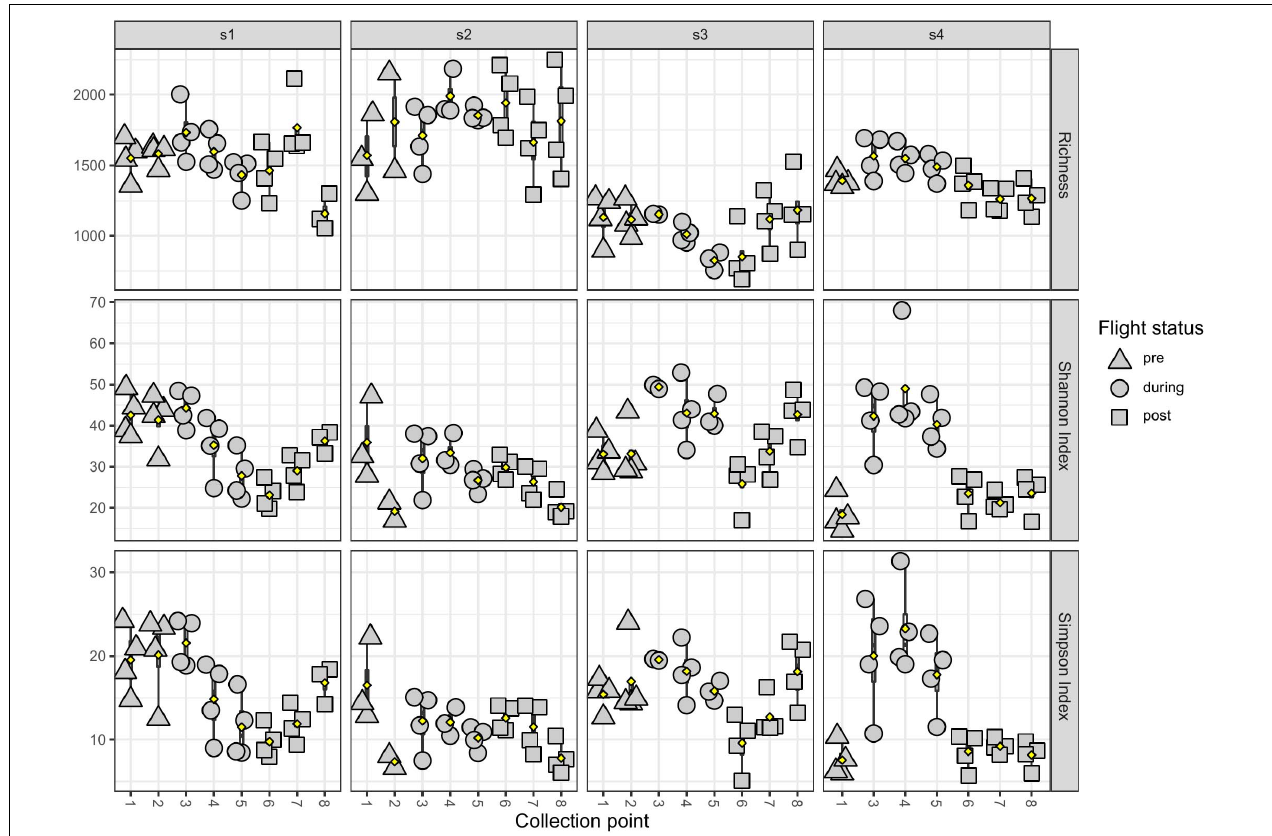
FIGURE 4 | The observed species richness and evenness of astronaut saliva samples. The species richness (top row), Shannon index (middle row), and Simpson index (bottom row) are displayed by astronaut (s1 in the first column, s2 in the second column, s3 in the third column, and s4 in the fourth column) and samples are grouped by collection timepoints. The flight status of each sample is indicated by shape (pre-flight are triangles, during-flight are circles, and post-flight are squares).